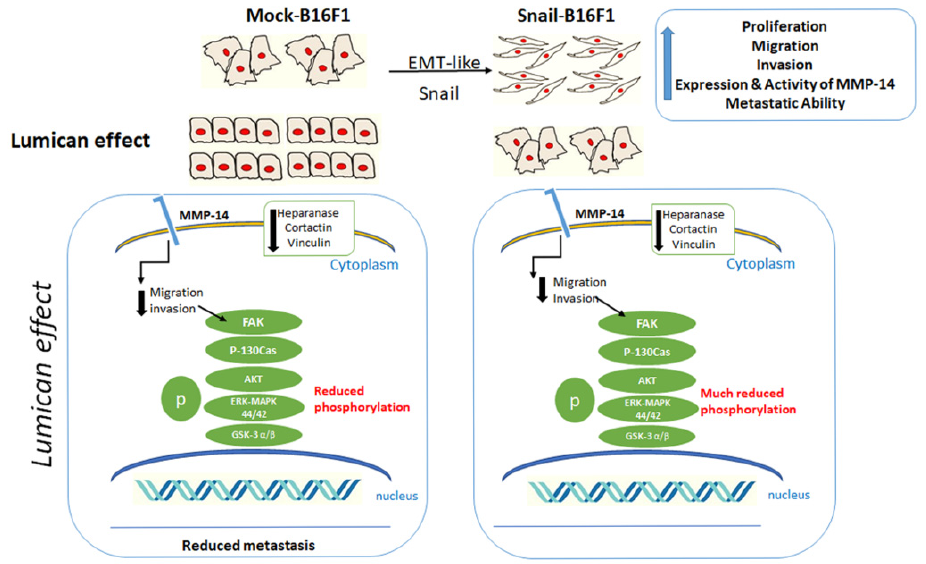
Figure 7. Diagram summarizing the major effects of lumican in melanoma cells before and after Snail transfection and potential lung metastasis. The action of lumican has been classified according to its effect on cell morphology, invadopodia markers (cortactin, heparanases), and RTKs (FAK, AKT, ERK-MAPK 44/42) according to Snail overexpression.